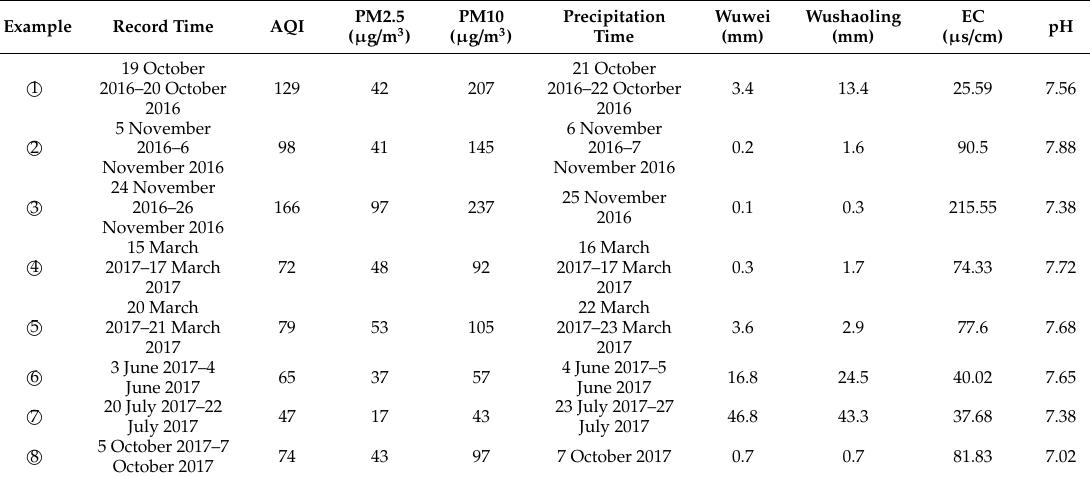
Figure 5. EC and pH of precipitation samples in dust weather. Table 3. EC and pH of precipitation samples in dust